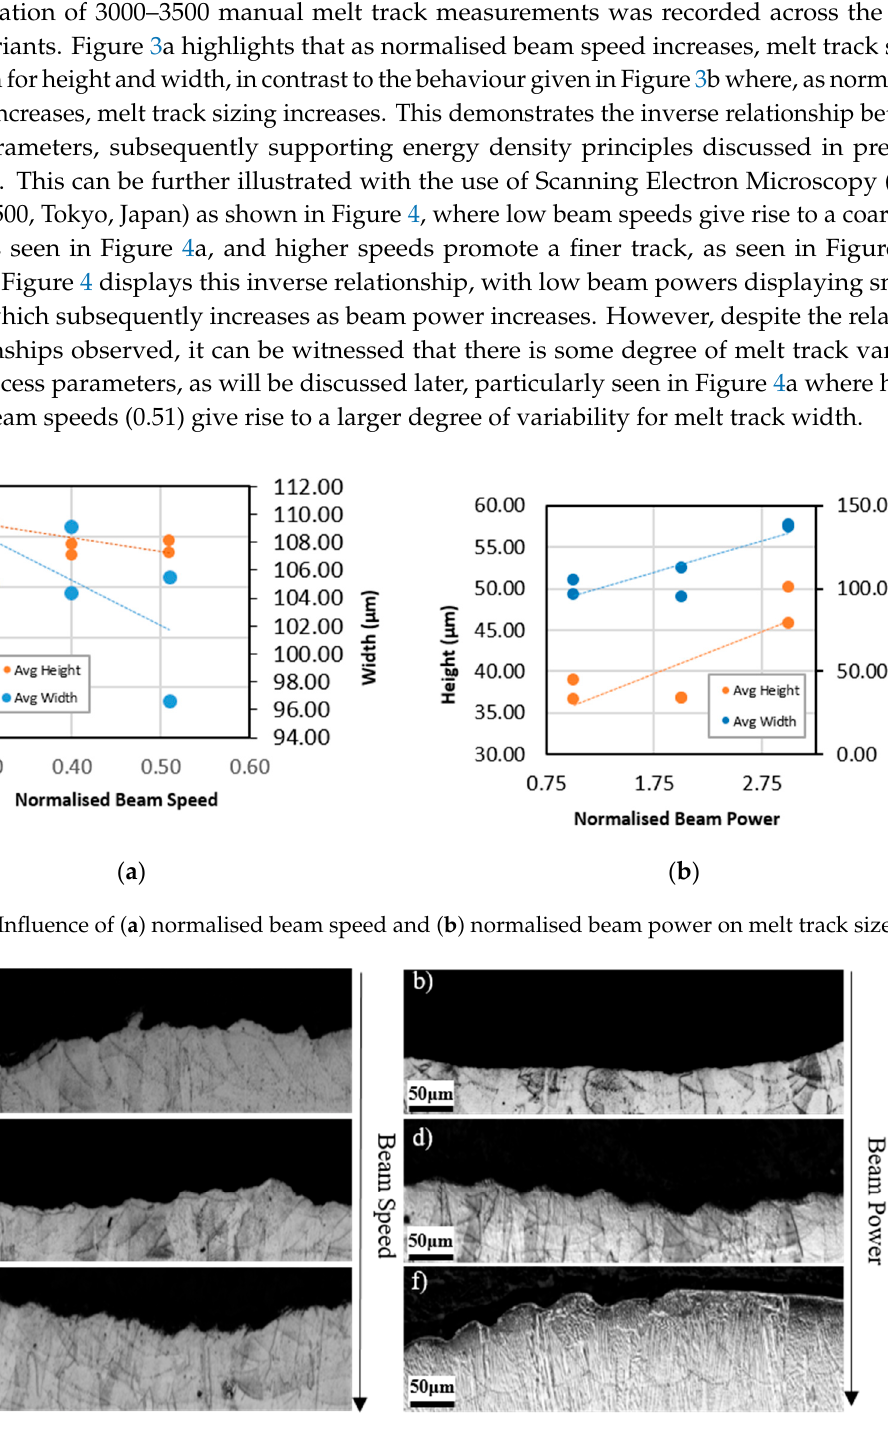
Figure 4. SEM micrographs illustrating the influence of beam speed ( a , c , e ) and beam power ( b , d , e ) on melt track sizing.